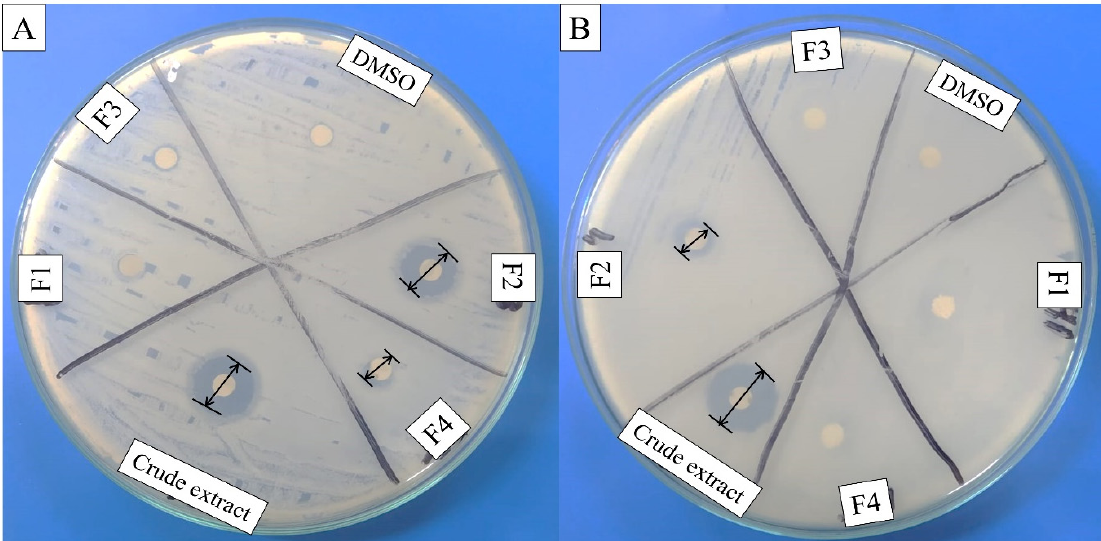
Figure 2. Antibacterial activity of ethyl acetate crude extract and column purified fractions (F1, F2, F3, and F4) against ( A ) E. coli (Gram-negative) and ( B ) S. aureus (Gram-positive). The DMSO (organic solvent) was used as negative control, while the disk diameter was 6 mm. Table 1. Details of the column chromatography and purified metabolite.